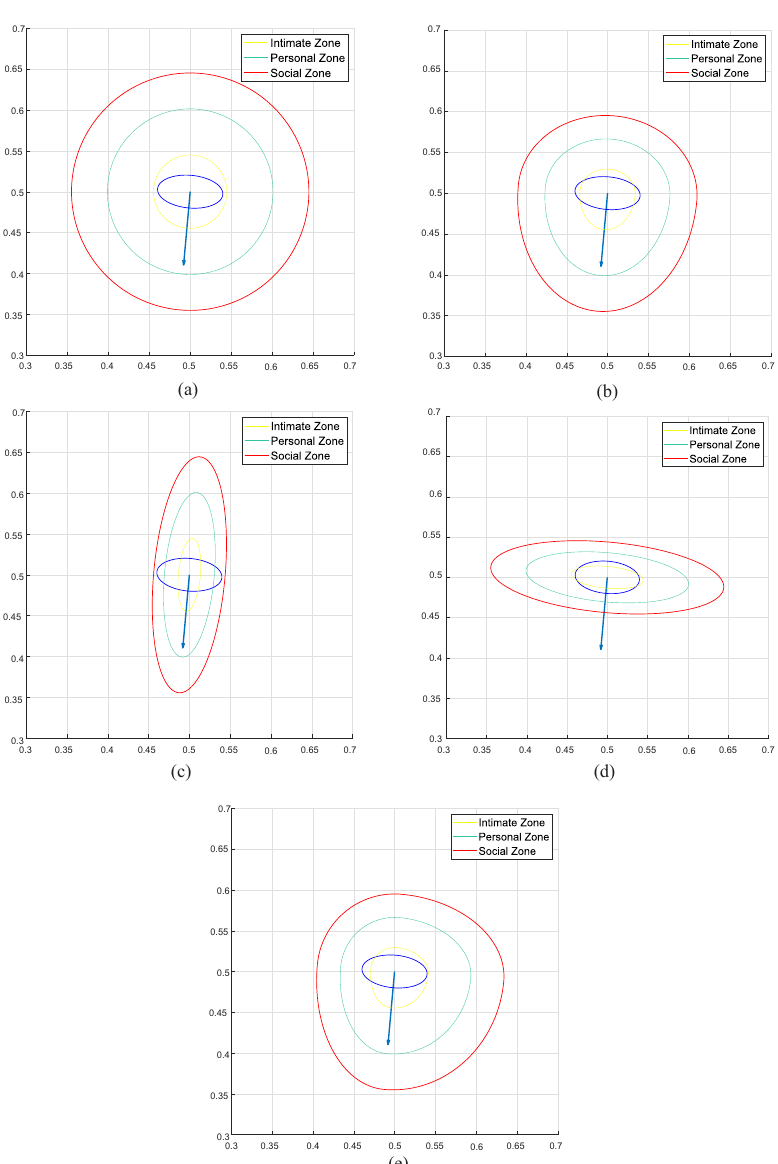
Figure 13. Gaussian Shapes: ( a ) Concentric Circles, ( b ) Egg Shape, ( c ) Ellipse Shape, ( d ) Ellipse Shape, and ( e ) Dominant Side.